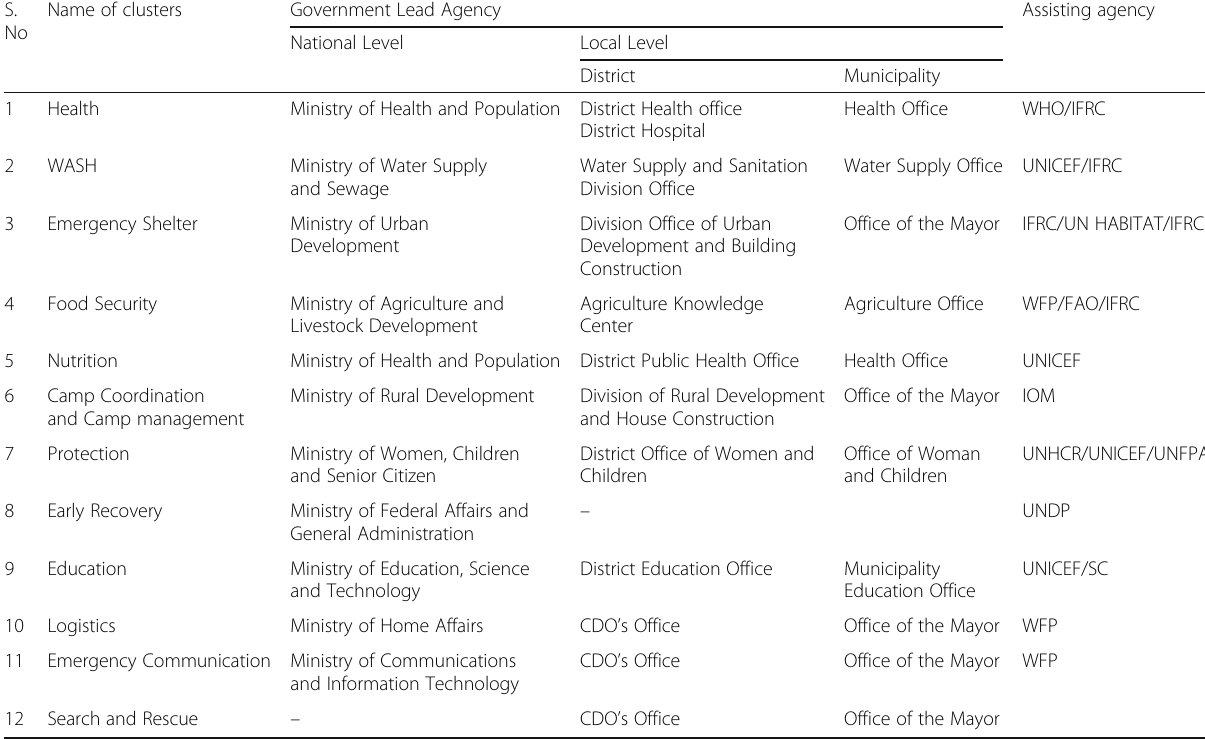
Table 1 Clusters at national and local level S. Name of No